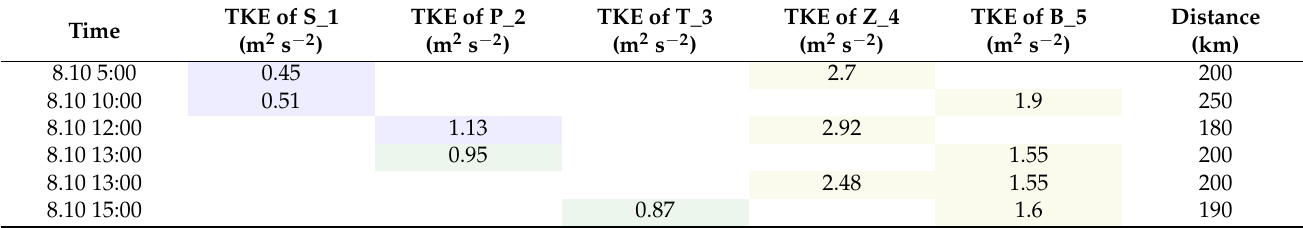
Table 6. TKE values for each station at the same time, at the same distance from the typhoon center, but distributed in different quadrants. Color shading indicates the quadrant, as in Figure